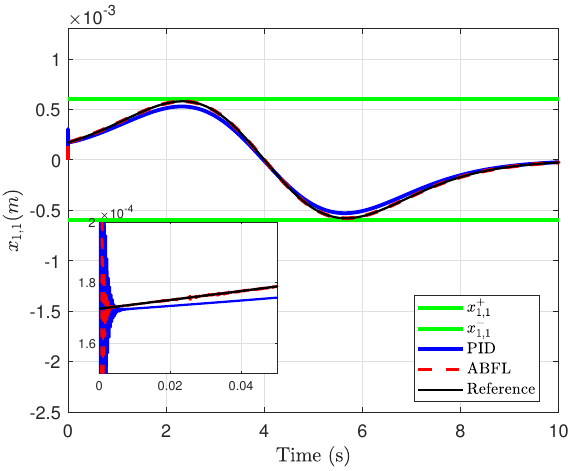
Figure 3. Tracking trajectory of